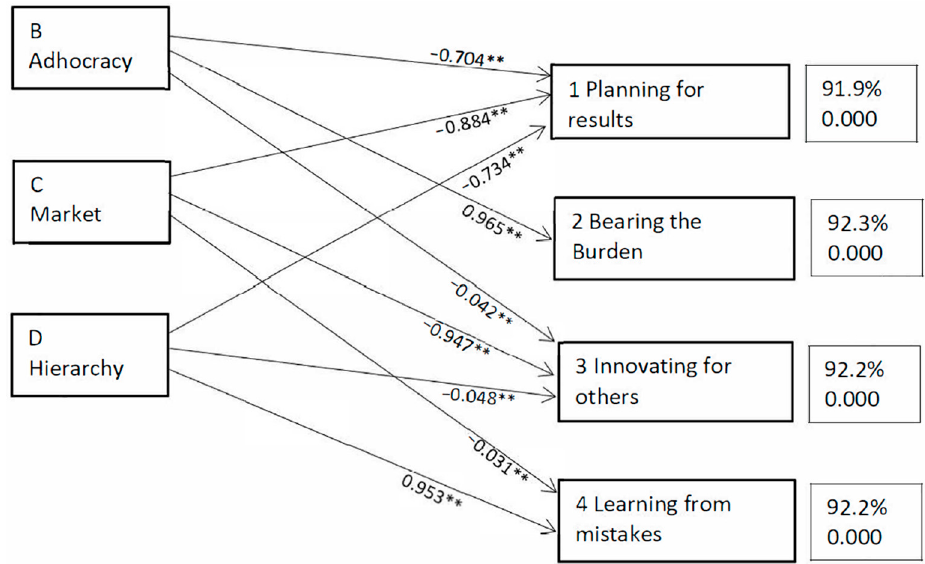
Figure 1. Linear regression model of entrepreneurial groupings (components) and preferred culture type (excluding clan type).